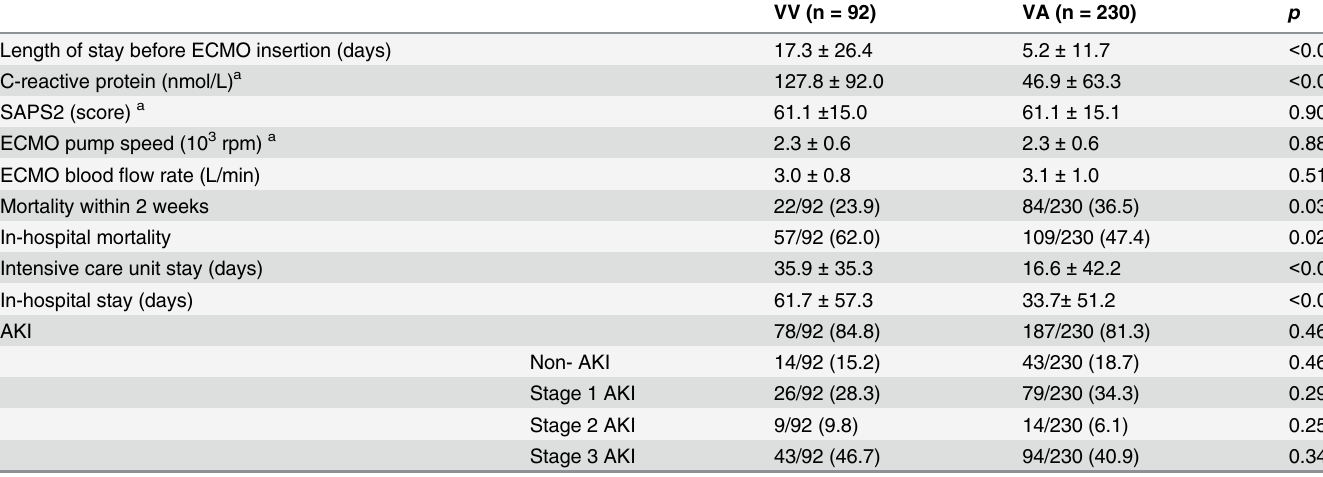
Table 4. Clinical characteristics according to the mode of